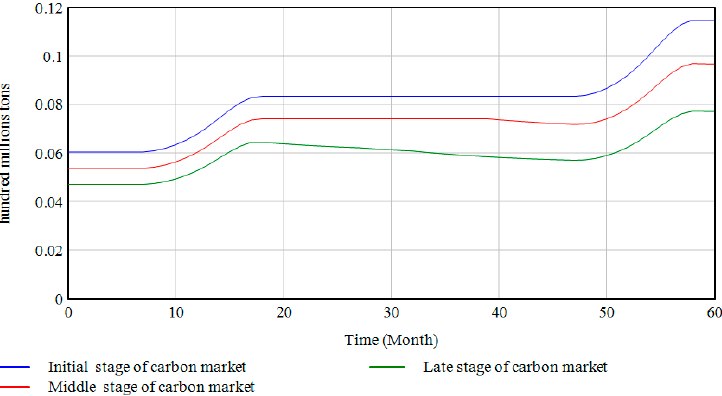
Figure 14. Trend of change in carbon emissions of the seller thermal power generators in the Beijing–Tianjin–Hebei region.